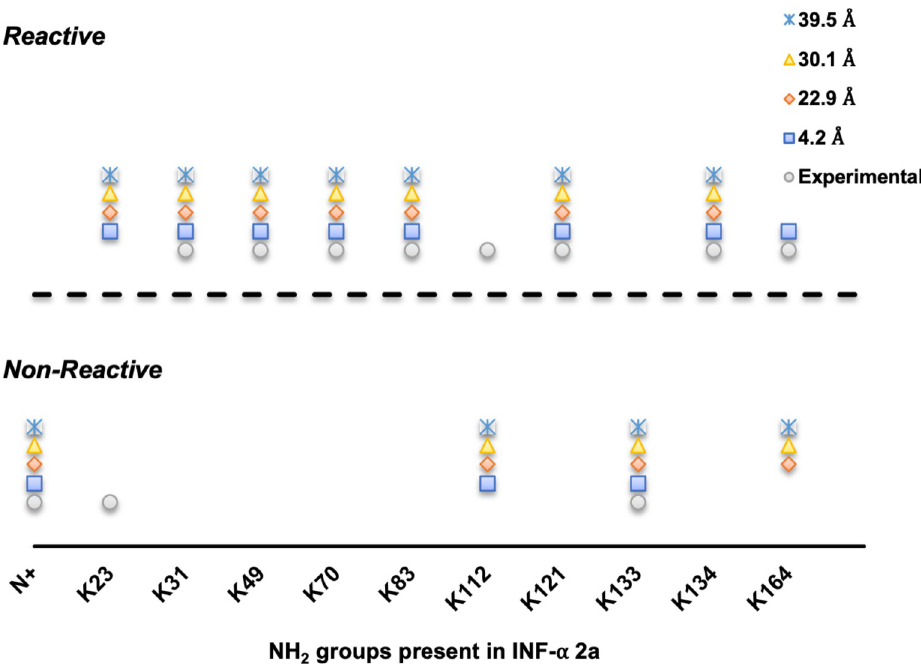
Fig 5. Comparison of PRELYM analysis of amine reactivities in interferon- α 2a with increasing probe radius. Increased probe radius does not improve amine reactivity prediction when considering PEGylation reactions and can lead to errors in amine residue